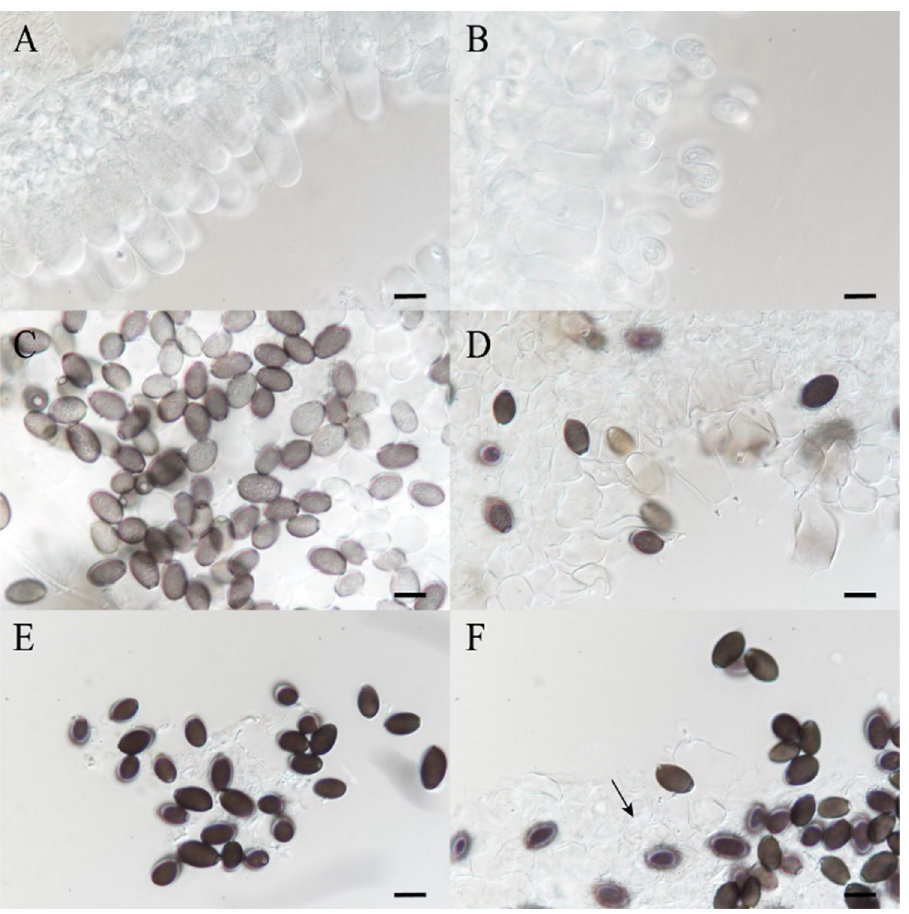
Figure 11. Microscopic characteristics of lamellae and basidiospores in four stages of fruiting body development in C. comatus . ( A ) Infant stage; ( B ) mature stage; ( C ) Basidiospores in the discolored stage; ( D ) Basidia in the discolored stage; ( E ) Basidiospores in the autolysis stage; ( F ) Basidia and hyphae of trama in the autolysis stage. Scale bars 10 μm. Note: The arrow in ( F ) indicates broken cell walls.